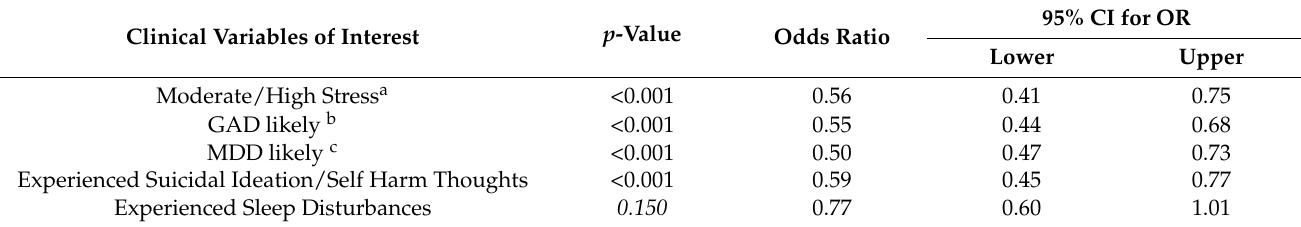
Table 4. Odds for subscribers in the IG to have various clinical characteristic compared to the